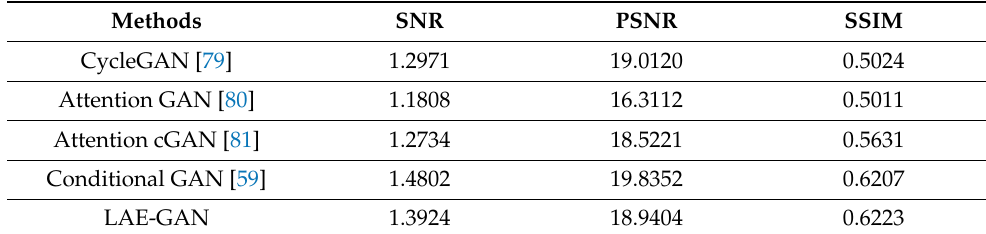
Table 5. Comparative accuracies of enhancement by our network and the state-of-the-art methods. Methods